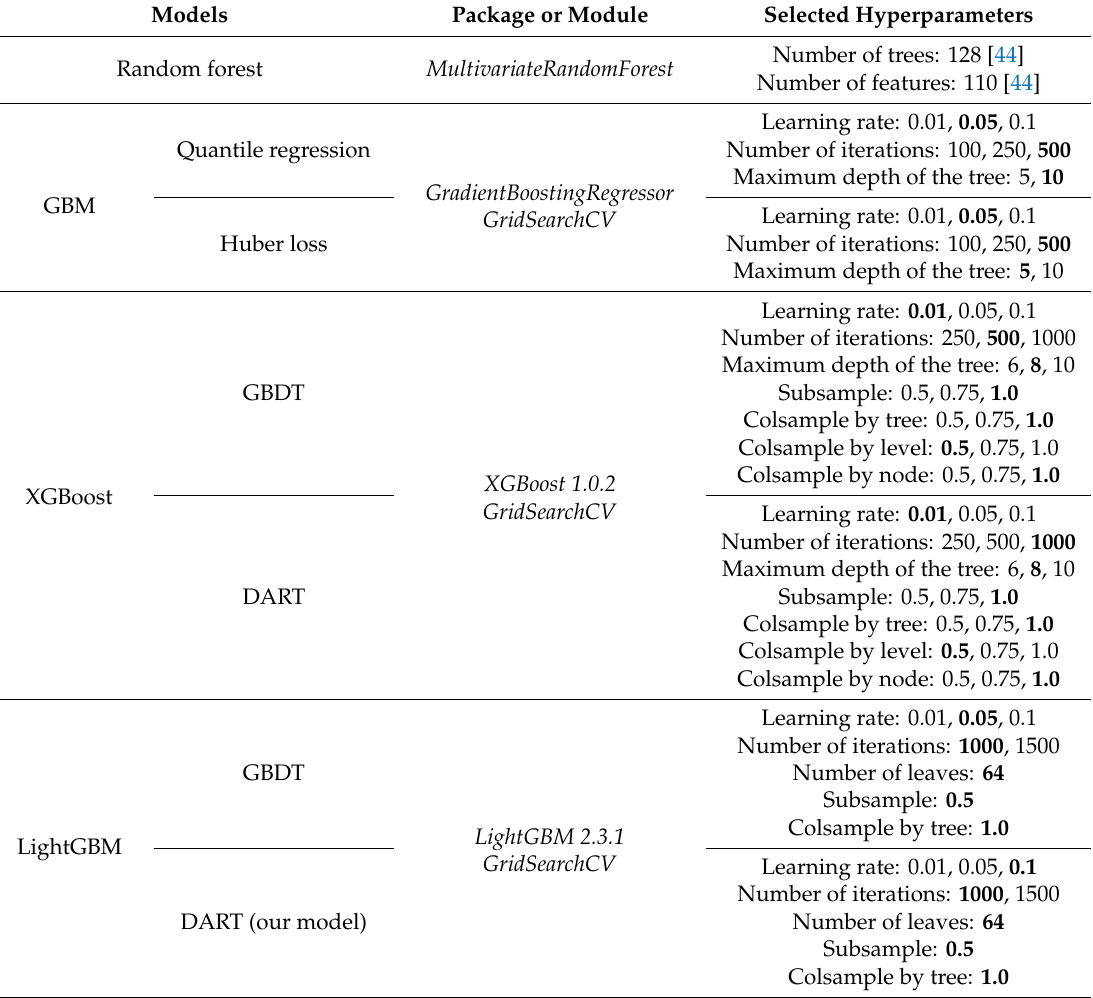
Table 4. Selected hyperparameters for each ensemble learning model. Selected values are bold. Models Package or Module Selected Hyperparameters Random forest MultivariateRandomForest